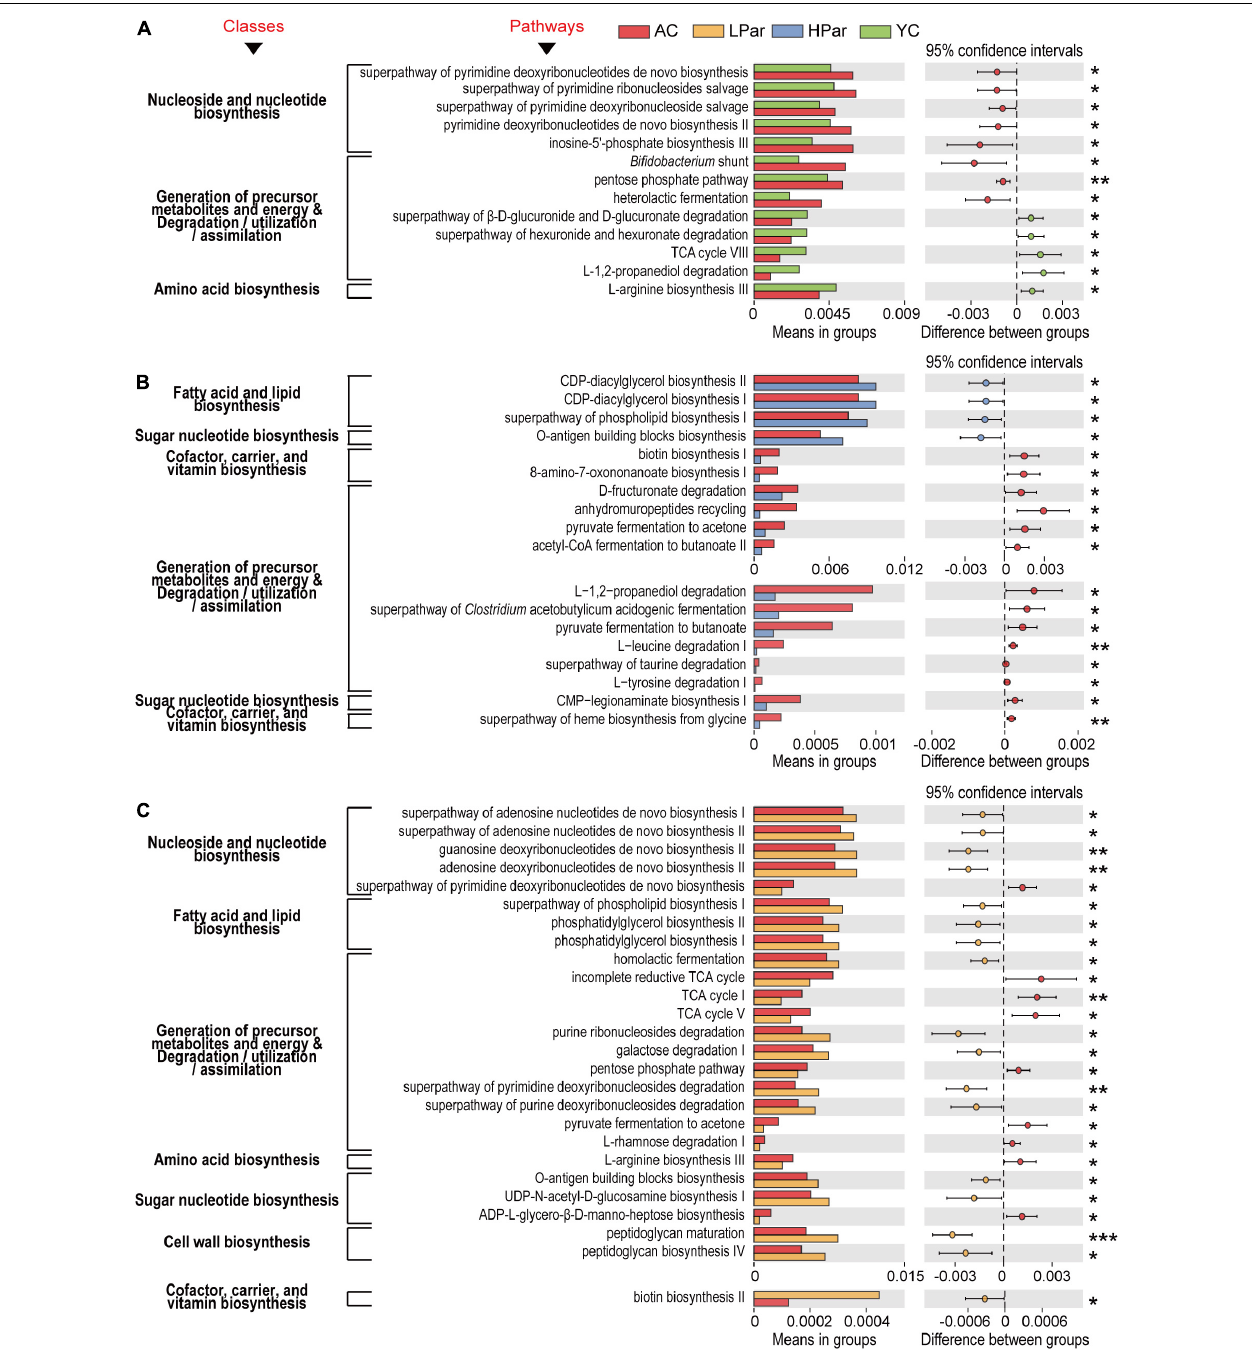
FIGURE 4 | Pathways of gut microbial genes altered by aging (A) and whose alterations were alleviated by high-dose parshin treatment (B) and low-dose parshin treatment (C) . * P < 0.05; ** P < 0.01; *** P <